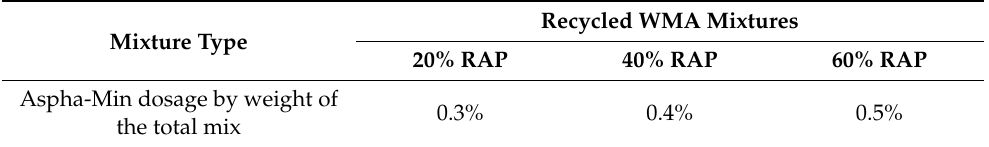
Table 13. Aspha-min dosage within the recycled WMA mixtures.